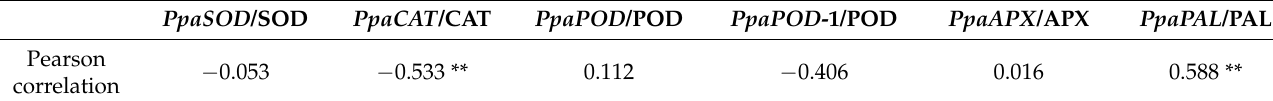
Table 1. Pearson Correlation analysis of enzymatic activity and related gene expression.